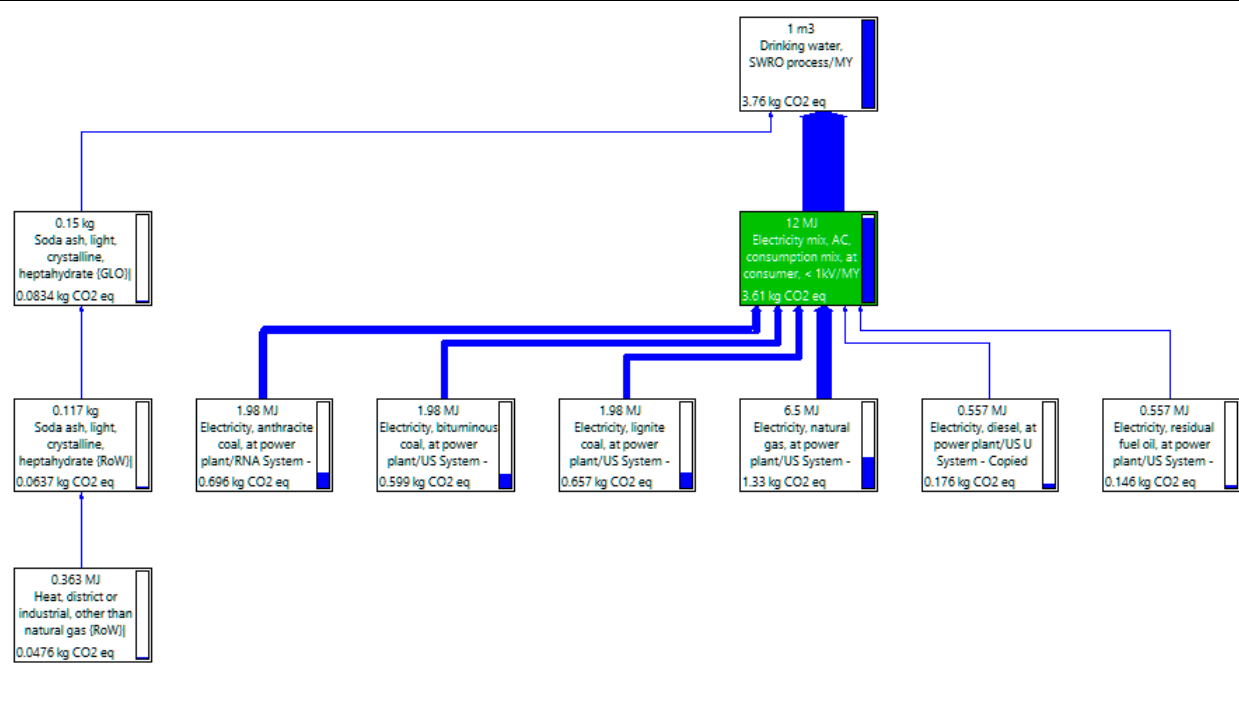
Figure 6. Dendrogram of the main contributions to GHG emissions per cubic meter of SWRO from chemicals (4%) and electricity (96%) factors.